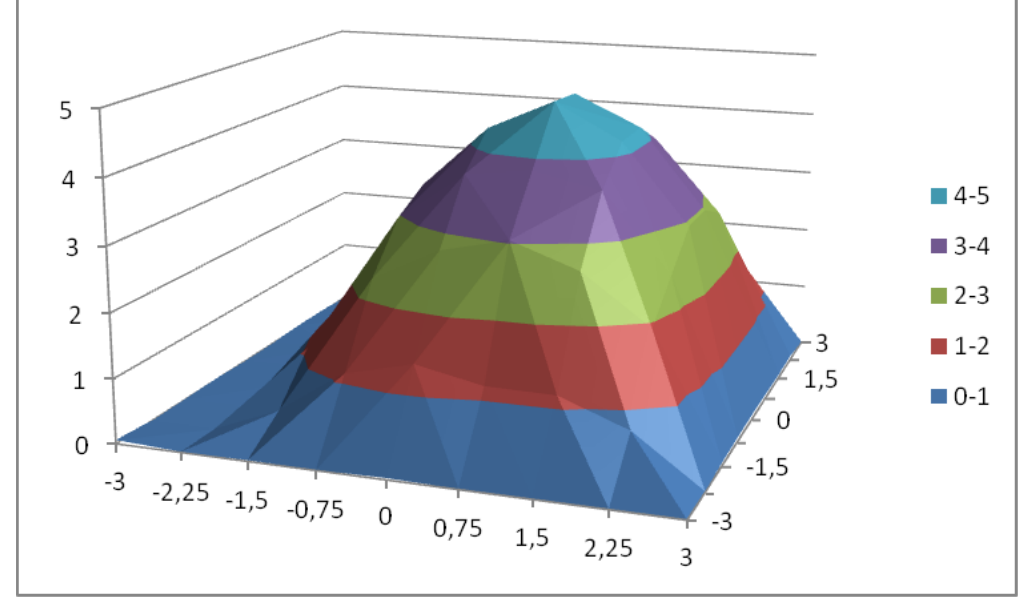
Figure 11. Electrical current generated in an elevation and azimuth sector of ±3°.